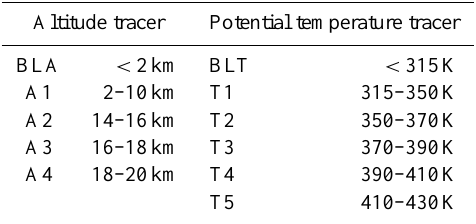
Table 1. Specification of passive tracer layers. The tracers carry an amount of 1 in these layers and are 0 outside at the time of tracer initialisation at